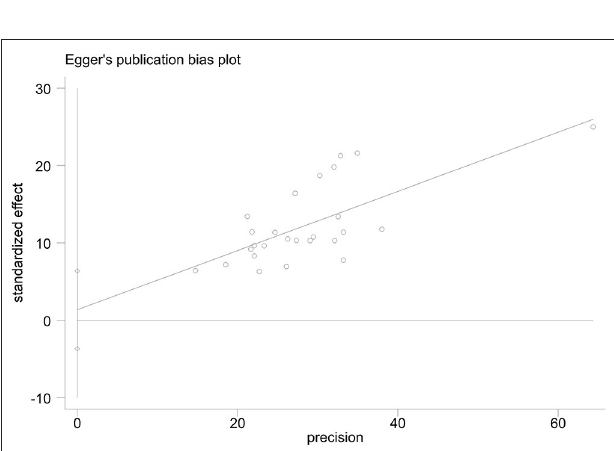
FIGURE 9 | Egger’s test of the 26 studies included in the